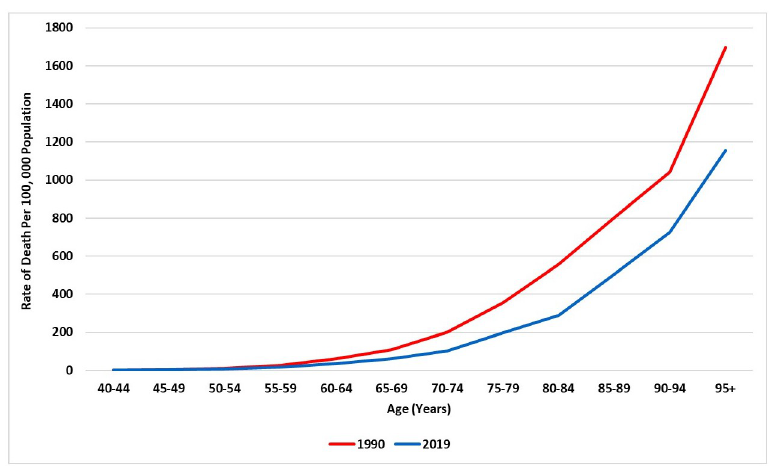
Fig 8. The death rate of COPD in Saudi Arabia (1990 and 2019), stratified by age.